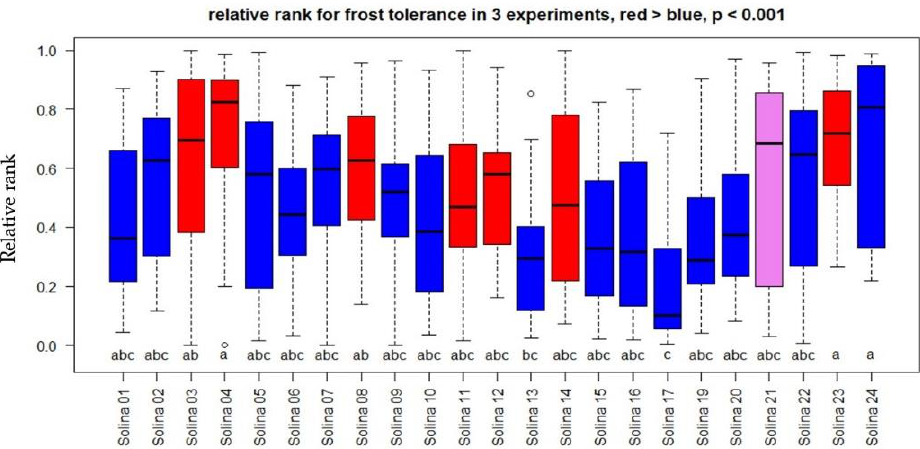
Figure 5. Relative rank of frost tolerance in three freezing stress experiments at −14 °C. The colour of the boxes indicates membership to the red and blue clusters according to De Flaviis et al. [5], with Solina 21 belonging to the blue cluster closest to the red cluster shown in purple. Relative ranks did not differ significantly for accessions with the same letter according to Kruskal-Wallis test and multiple comparison with Bonferroni